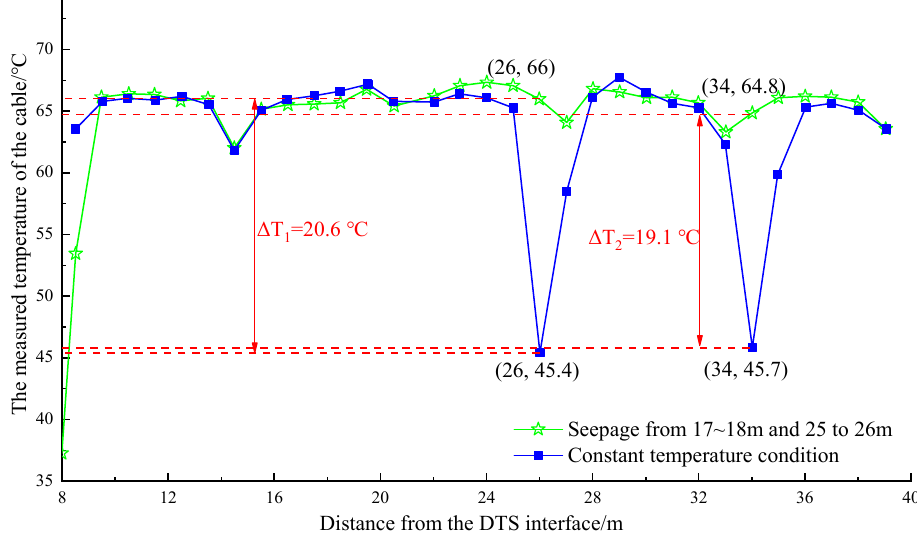
Figure 16. Temperature drop curve at the position of 17~18 m, 25~26 m in the pipeline. The temperature dropped after watering at 25–26 m and 28–29 m away from the DTS joint are shown in Figure 15. In the range of 25–27 m, the maximum temperature dropped to 18.2 ◦ C, and the minimum temperature was 47.8 ◦ C, which appeared at the position of 26 m. In the range of 28–30 m, the maximum temperature dropped to 18.8 ◦ C, and the minimum temperature was 47.9 ◦ C, which occurred at the position of 29 m. Watering was stopped, and the temperature on the optical cable line returned to stability. Figure 16 shows that in the range of 25–27 m, the maximum temperature dropped to 20.6 ◦ C, and the minimum temperature was 45.4 ◦ C after watering at 25–26 m and 33–34 m away from the DTS joint, which appeared at the position of 26 m. In the range of 33–35 m, the maximum temperature dropped to 19.1 ◦ C, and the minimum temperature was 45.7 ◦ C, which occurred at the position of 34 m. In general, the artificial cooling area and the abnormal temperature area measured by the optical cable had good correspondence. The error was within 1 m, and the abnormal temperature difference anomaly ∆ T was approximately 18 ◦ C,